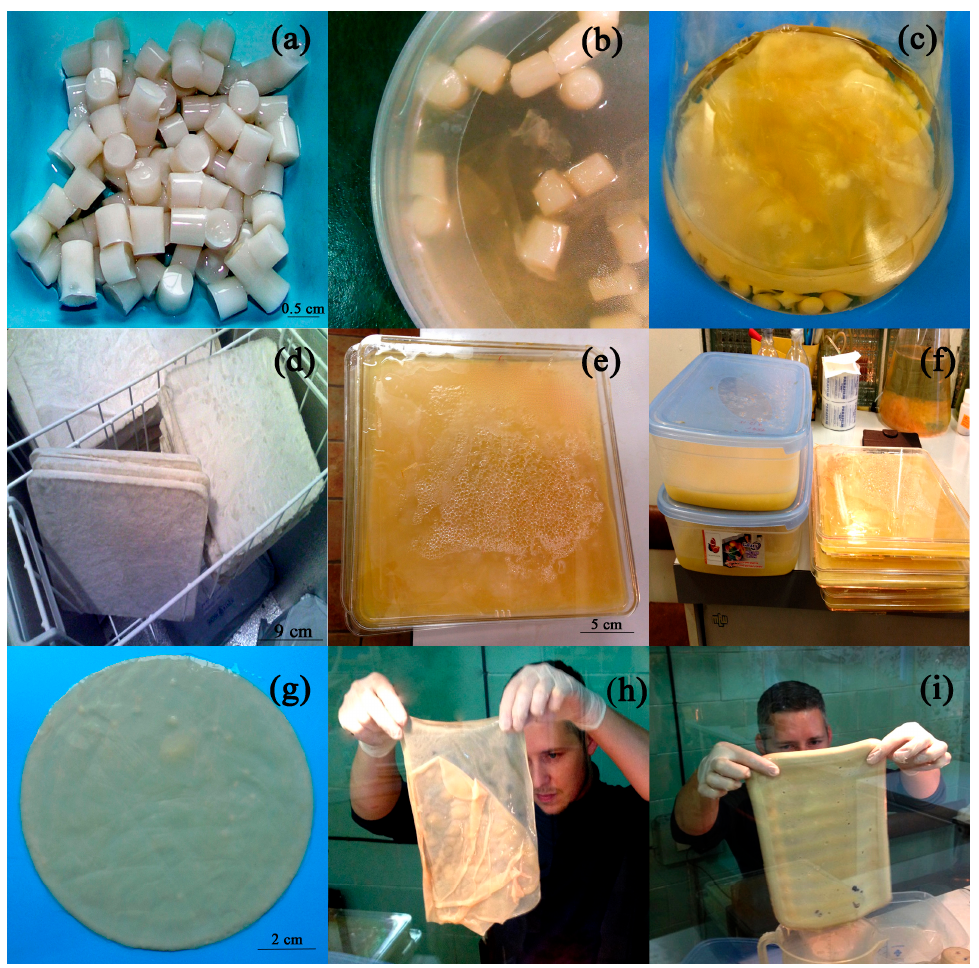
Figure 2. Bacterial cellulose (BC) production by immobilized Komagataeibacter xylinum cells. Images of immobilized biocatalysts based on poly(vinyl alcohol) (PVA) cryogel in the form of granules ( a – c ) or sheets ( d – f ); beginning of BC appearance from the granules with immobilized cells ( b ); PVA cryogel